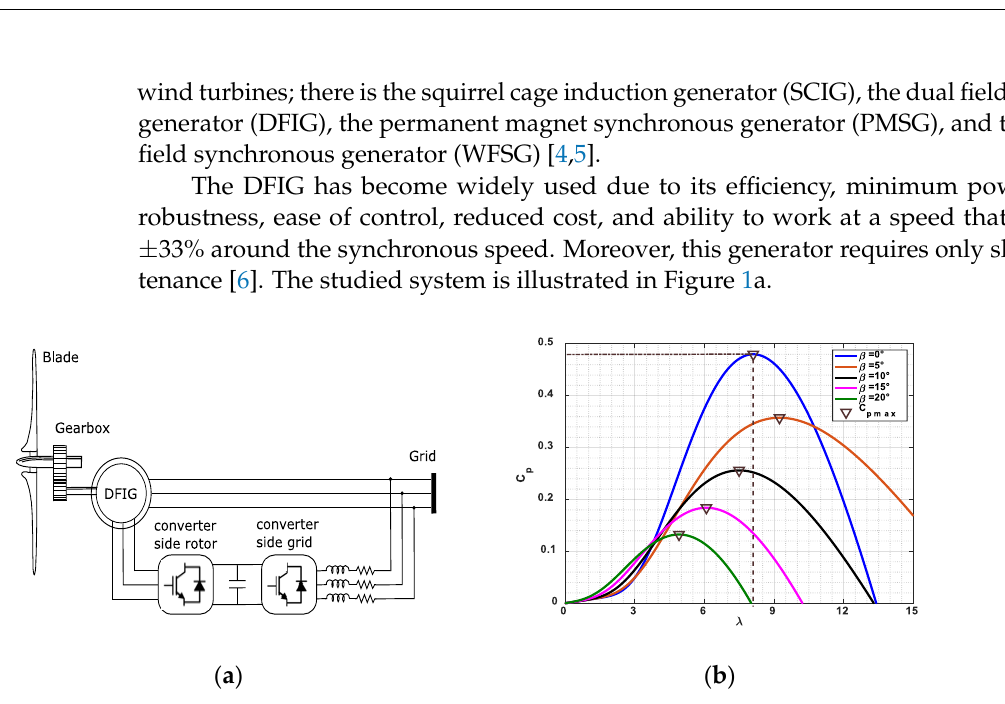
Figure 1. ( a ) Wind energy conversion system (WECS) based on a direct drive dual field induction generator (DFIG); ( b ) curves of the power coefficient (𝐶 𝑝 ) as a function of 𝜆 and 𝛽 .